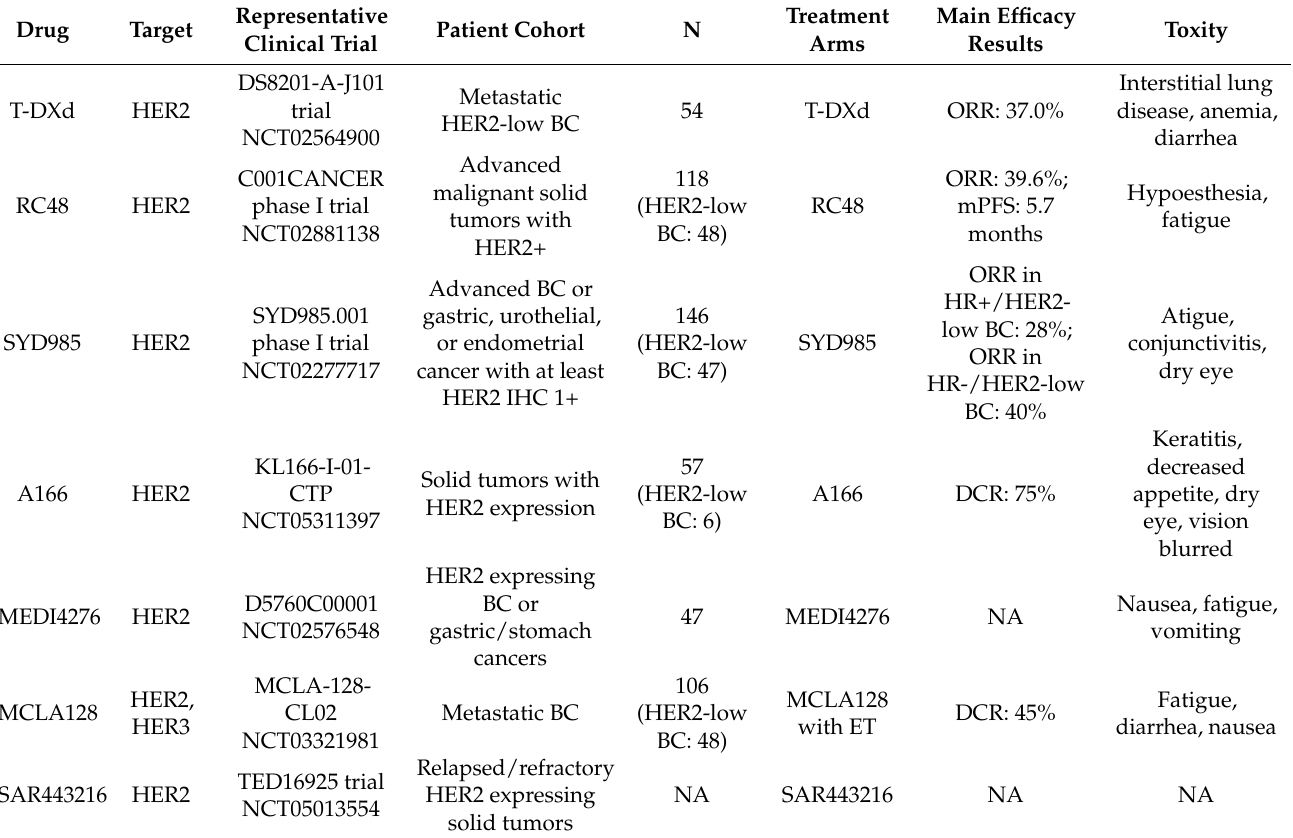
Table 1. Summary of novel drugs targeted HER2 receptors in development for HER2-low